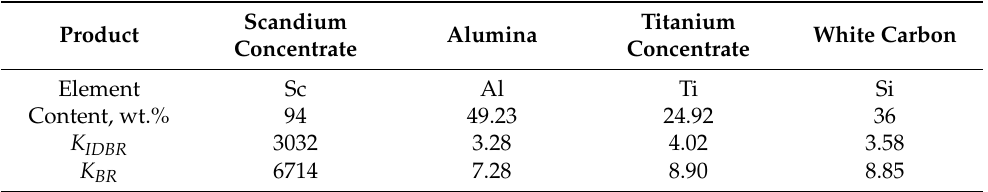
Table 10. Enrichment ratios of the obtained valuable products.